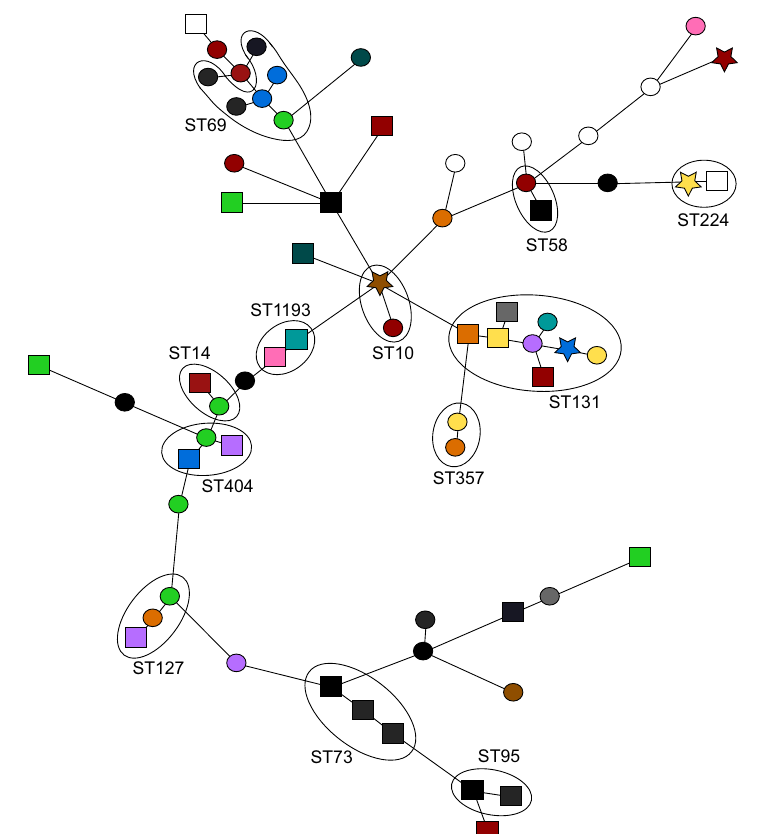
Fig. 2 Minimum spanning tree of whole genome multilocus sequence typing results of 66 E. coli isolates. Circles/squares/stars represent one isolate, which is connected to the closest relative. The circles represent colistin-susceptible isolates, the squares colistin-resistant isolates and the stars colistin- resistant isolates with mcr genes. The length of the lines in between the isolates is proportional to the allelic distance. Groups of isolates with the same classical MLST sequence type are indicated in the fi gure, e.g. ST131. The colours represent the different participating medical microbiology laboratories. A cluster was de fi ned as ≥ 2 isolates with an allelic difference of ≤ 25. There were no clusters observed for E. coli . Source data: Supplementary Data fi les 2 and